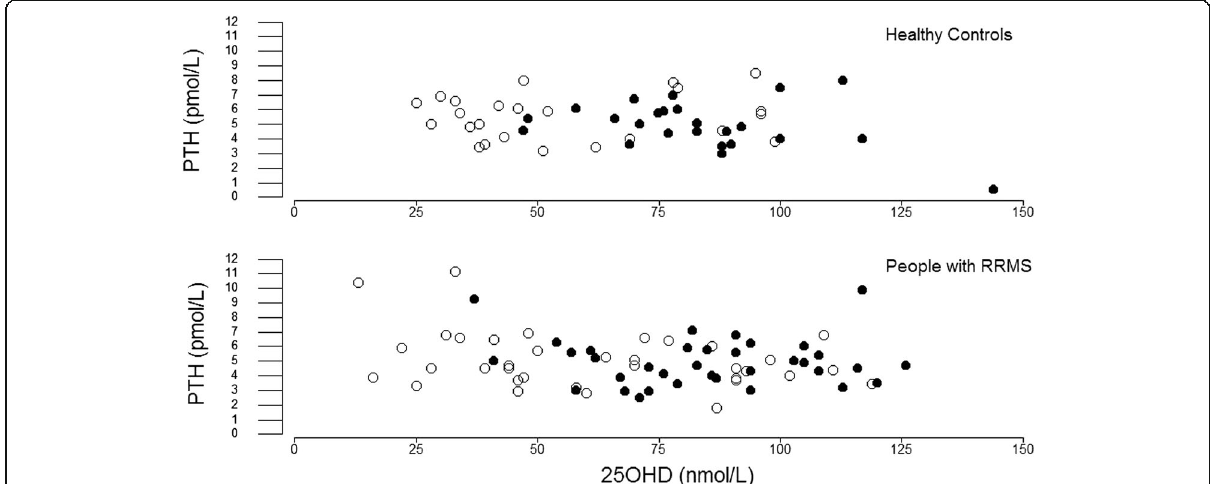
Fig. 5 Plasma PTH and Serum 25OHD Plasma PTH in winter (open circles) and summer (solid circles) plotted against serum 25OHD for subjects who provided both winter and summer venepuncture. Three outliers (serum 25OHD > 150 nM) were excluded to enlarge the scale of the